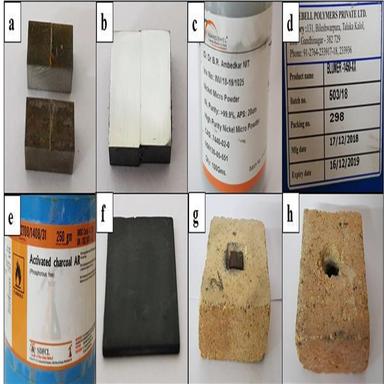
(a) specimen before joining; (b) Specimen after joining; (c) Interface powder; (d) Epoxy Blumer 1450-XX; (e) Susceptor powder; (f) Separator sheet; (g) Lower refractory brick; (h) Upper refractory brick.